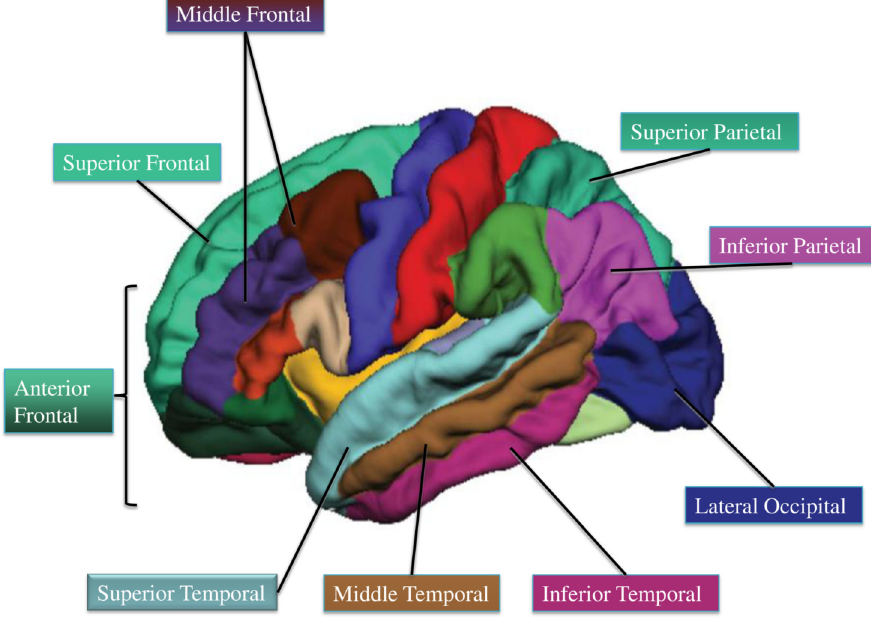
Fig 1. Cortical thickness regions of interest via Freesurfer (adapted from 43). Starred regions are areas in which higher fit children showed decreased cortical thickness compared to lower fit children.